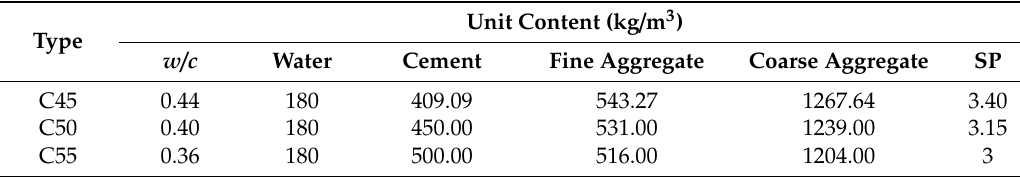
Table 2. Mix ratio of concrete test block.